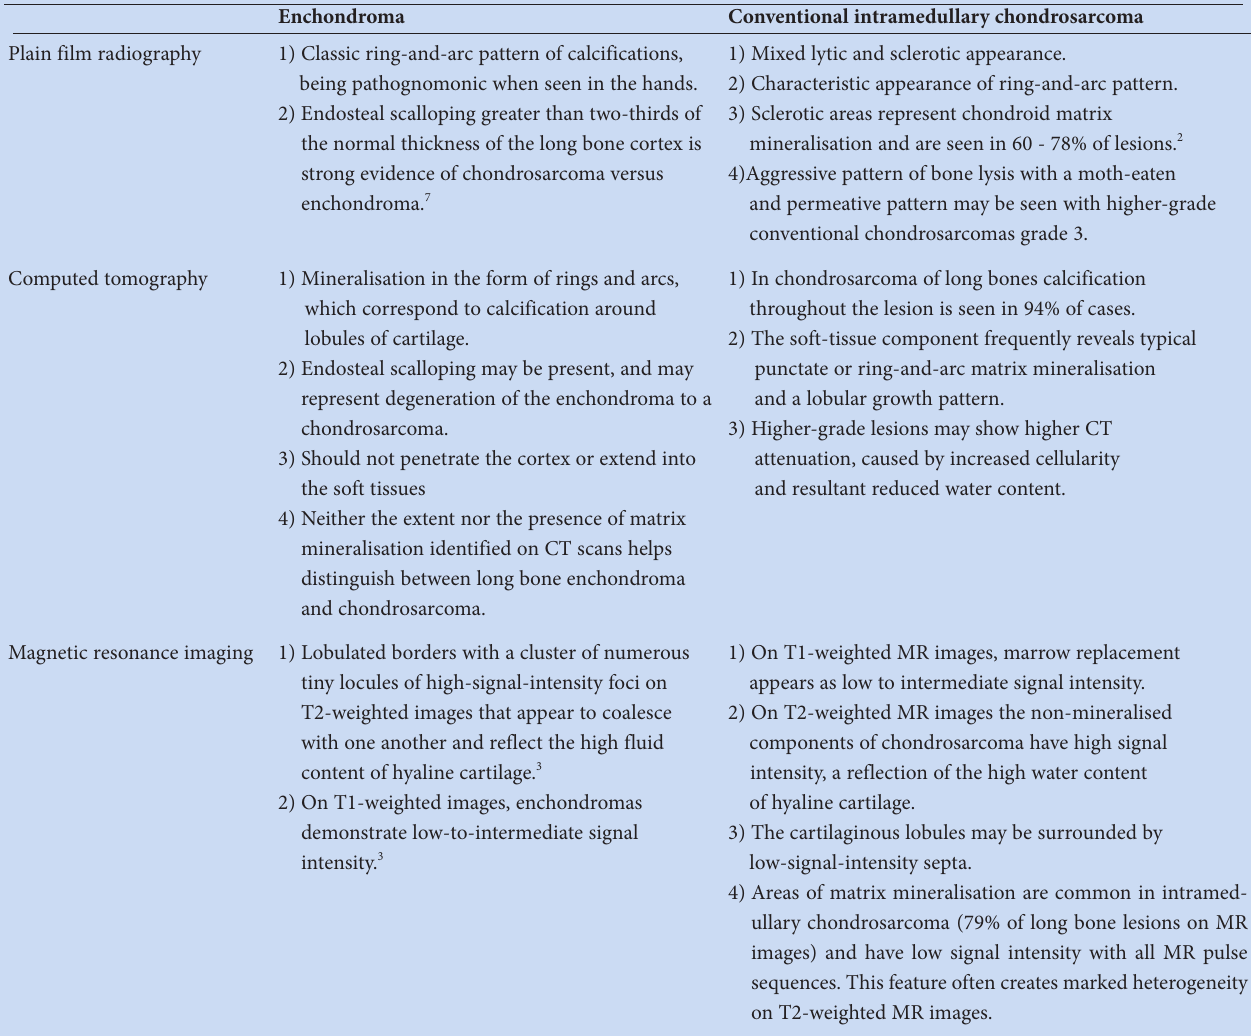
Table I. Common radiological features of enchondromas and chondrosarcomas on plain film, CT and MRI